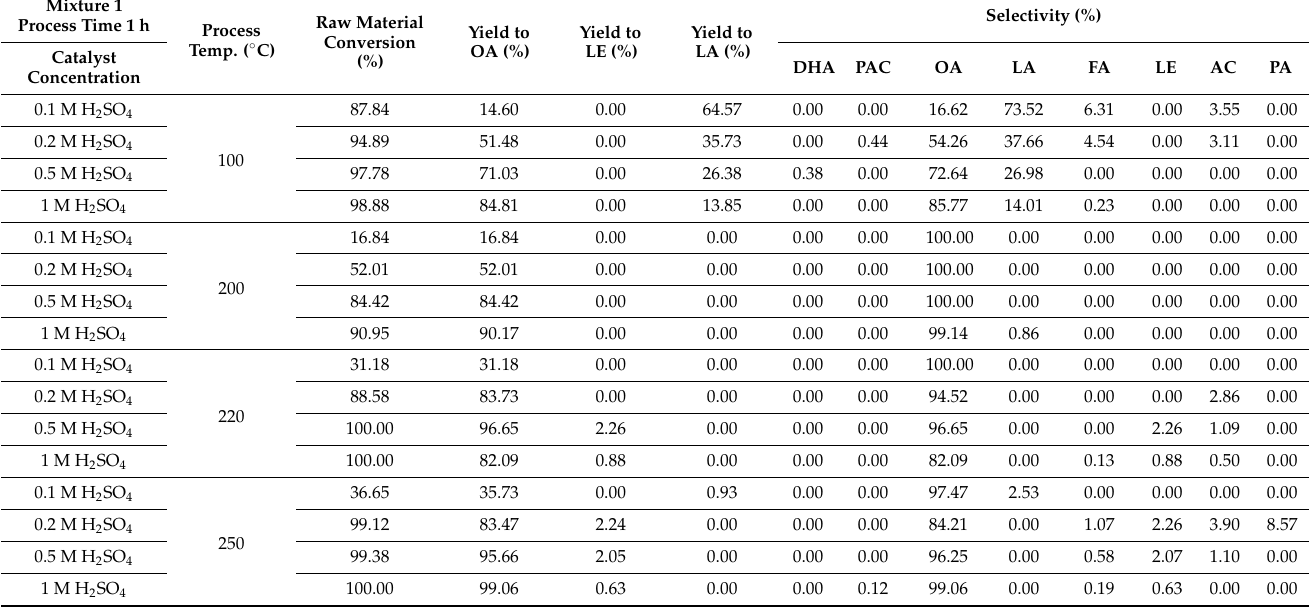
Table 1. The results of HPLC analysis for the catalytic conversion of hemicellulose carbohydrates using the homogeneous H 2 SO 4 catalyst in the liquid phase, with a 1 h process time for mixture